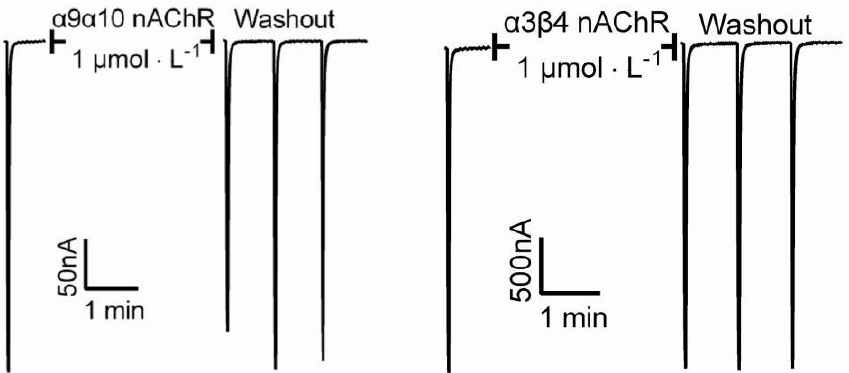
Figure 11. Inhibition of ACh-evoked currents mediated by α9α10 and α3β4 nAChRs .